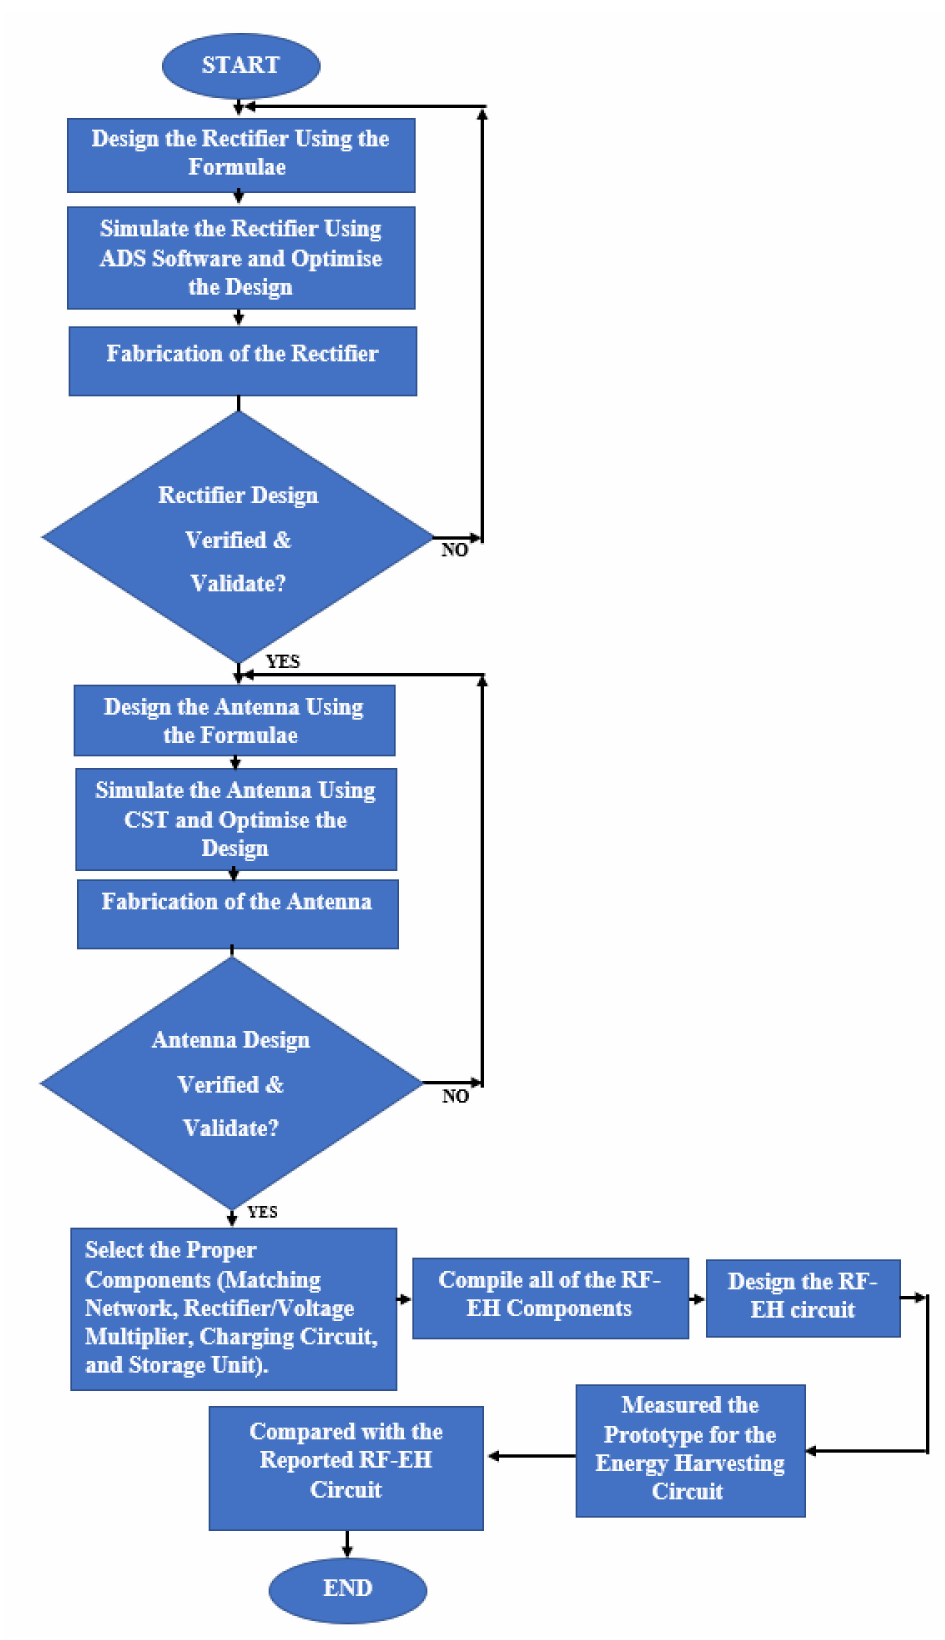
Figure 6. Methodology steps to design the radio frequency energy harvesting